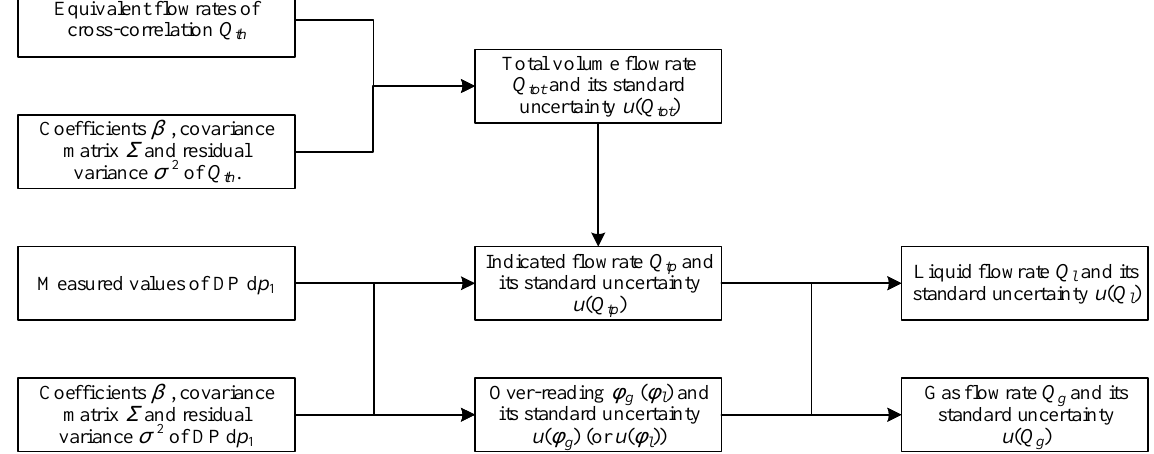
Figure 15. The calculation procedures of the cross-correlation and differential pressure (CC + DP) method. After the estimates of the total volume flowrate 𝑄 𝑡𝑜𝑡0 are obtained, 𝑄 𝑙 = 𝑄 𝑡𝑜𝑡 − 𝑄 𝑔